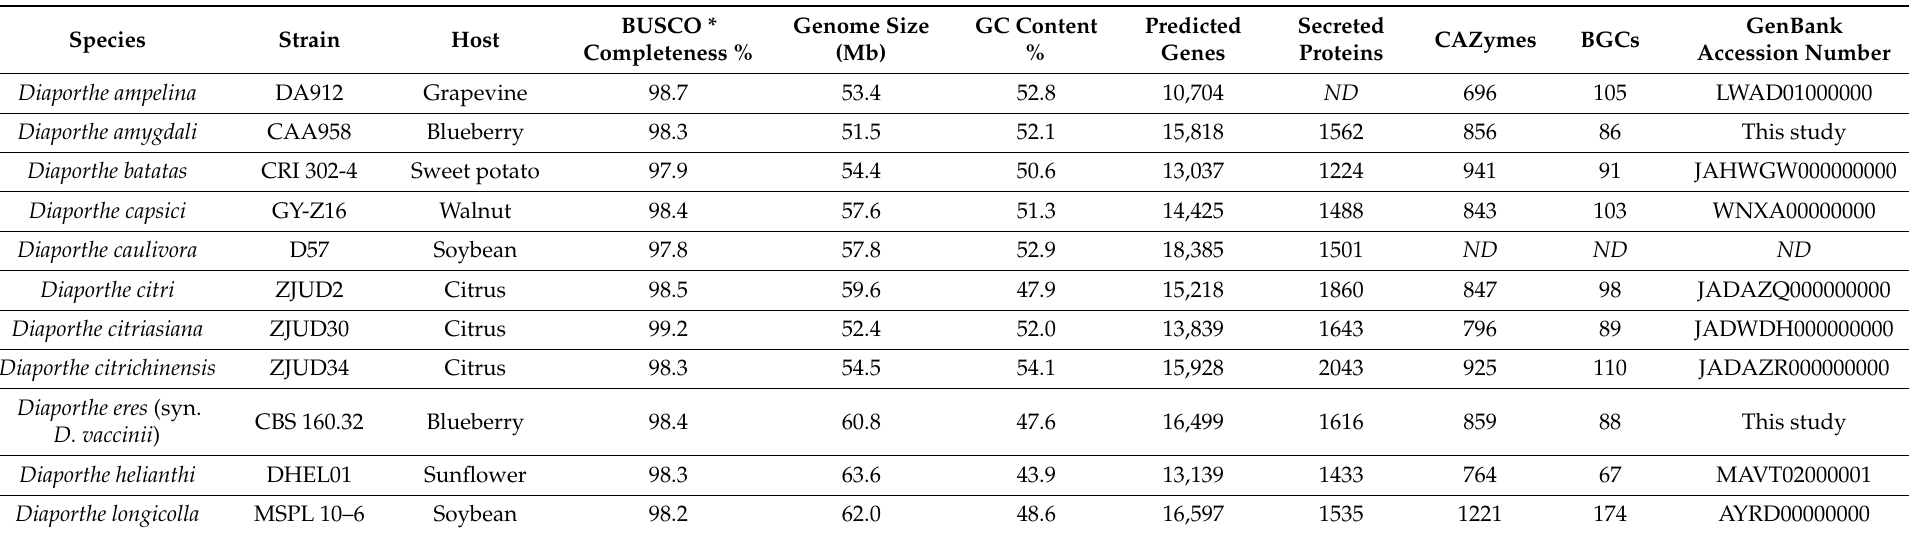
Table 5. Genomic features of the Diaporthe species analyzed: ND, no